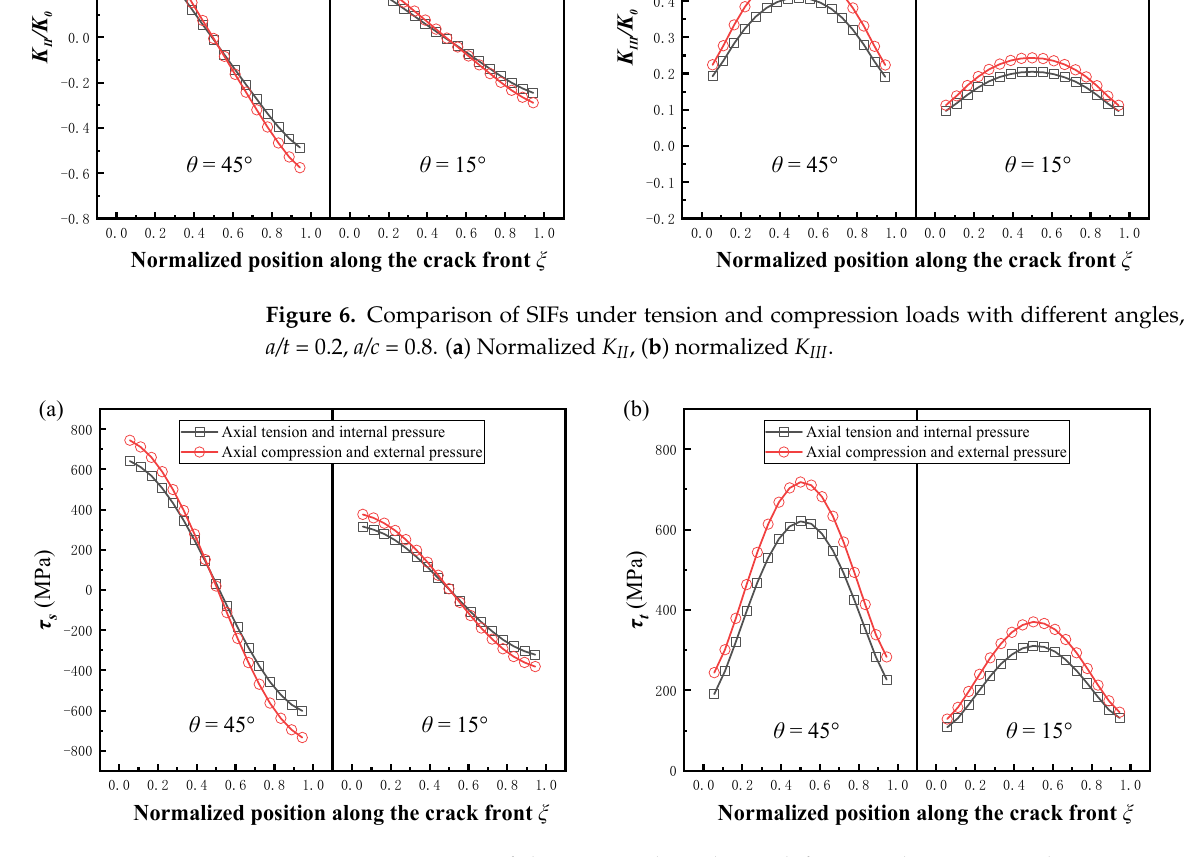
Figure 7. Comparison of shear stress along the crack fronts under tension and compression loads. ( a ) Shear stress along the crack front of mode II. ( b ) Shear stress along the crack front of mode III.